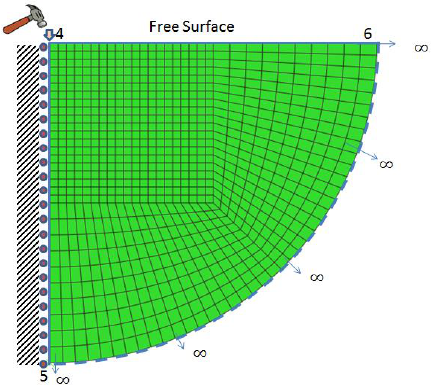
Figure 8. Quarter circular FE model of semi-infinite domain subjected to triangular impact